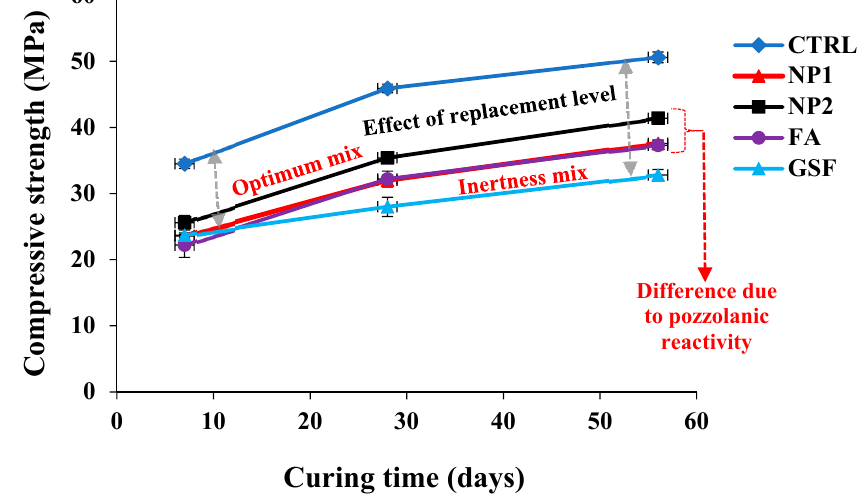
Figure 16. Comparison of compressive-strength development of normal concrete mixes containing NP1, NP2, FA, and GSF.